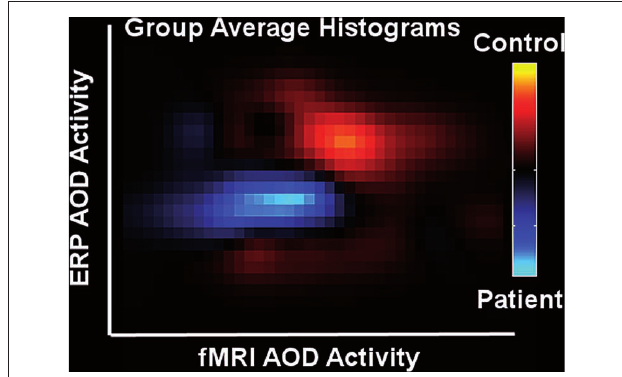
FIGURE 7 | ERP/fMRI histograms (from Calhoun and Adali, In Press). Joint histograms for patients (blue) and controls (orange).